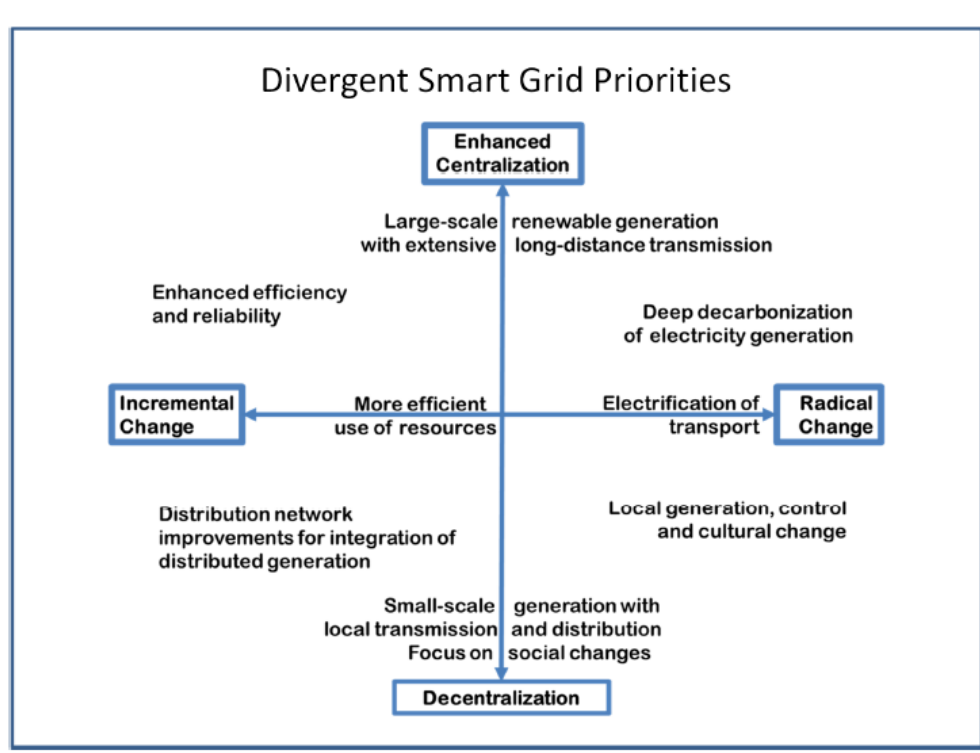
Figure 2. Actors’ vision of the potential of Smart Grid can be characterized by perceptions of the possibility and need for radical versus incremental change and perceptions of a future with enhanced centralization or